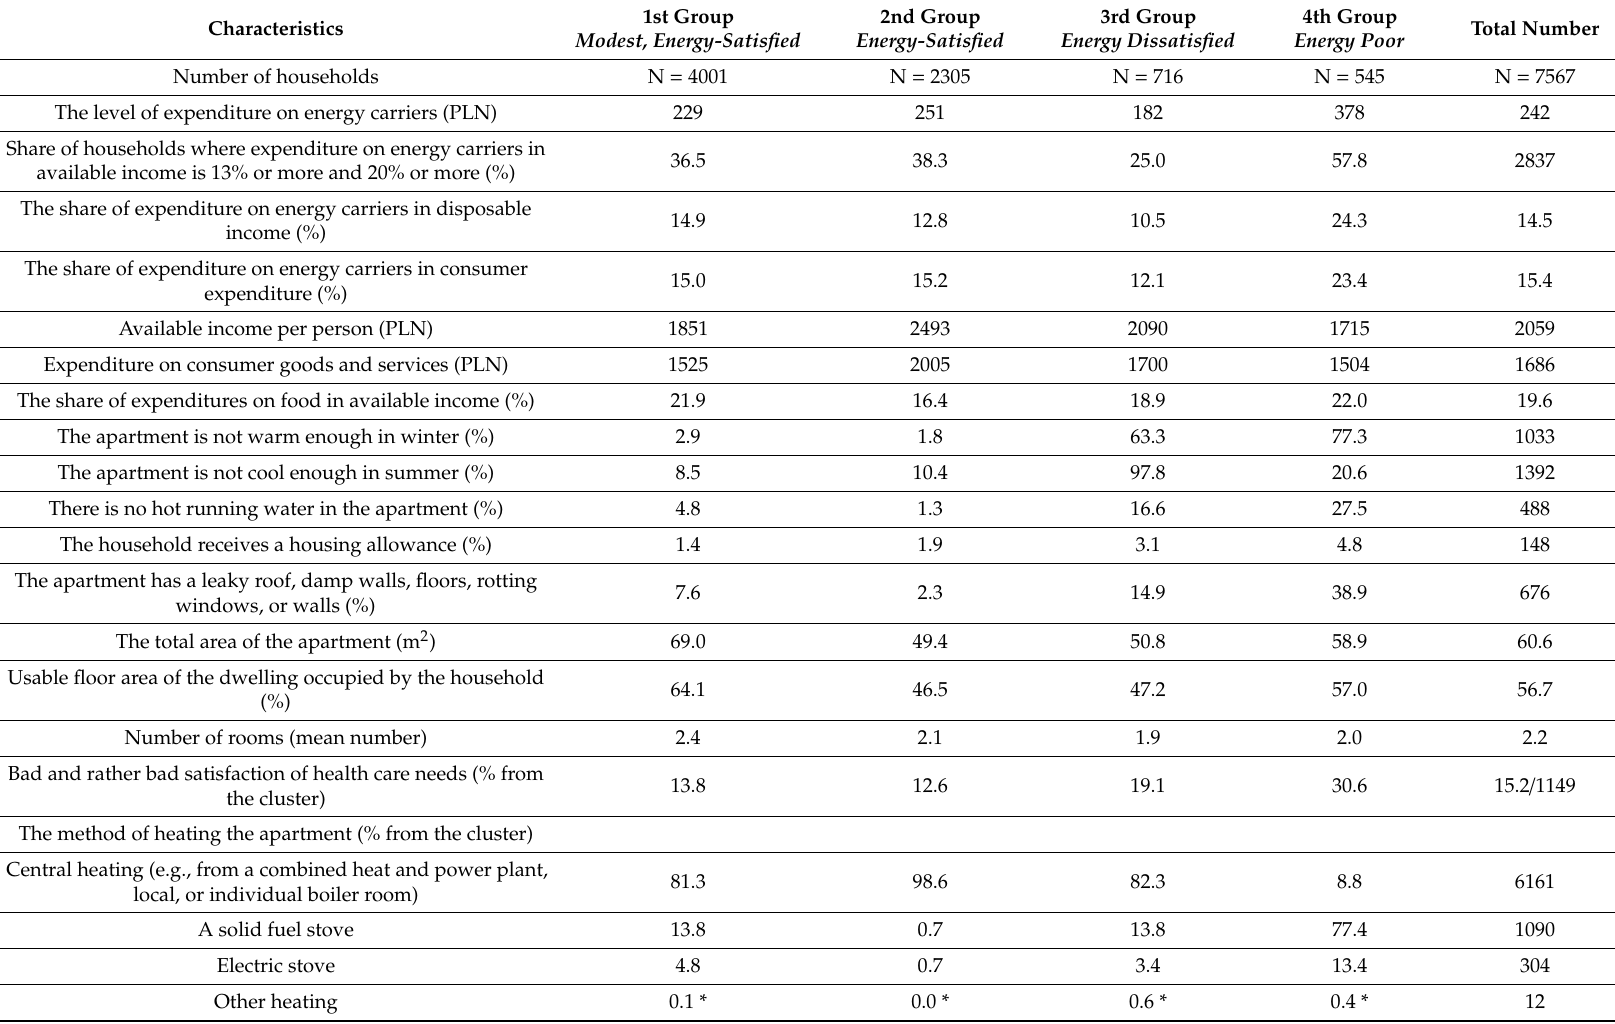
Table 5. Patterns of consumption of energy carriers of the types of one-person households in Poland in 2016.